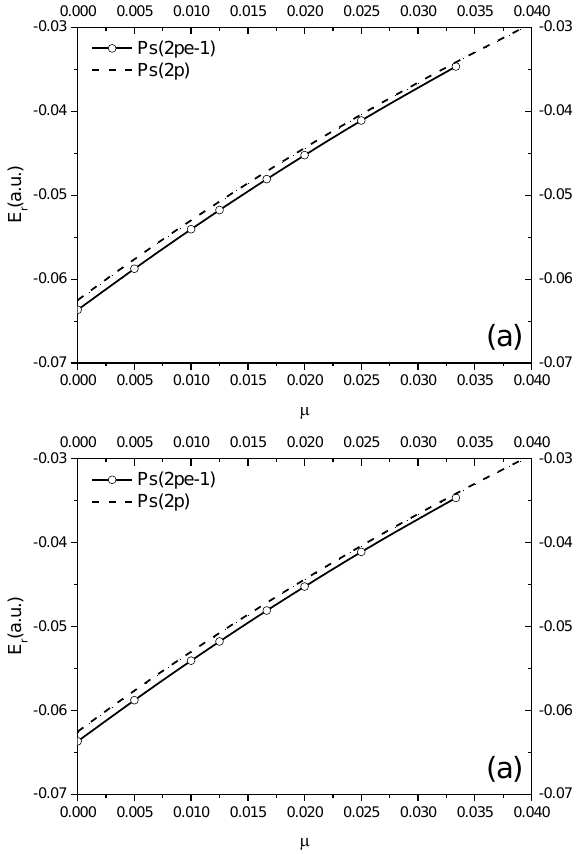
Figure 5. P -wave unnatural parity states: ( a ) resonance energy and ( b ) half-width for the Ps(2p e -1) state as a function of μ = 1/ D .